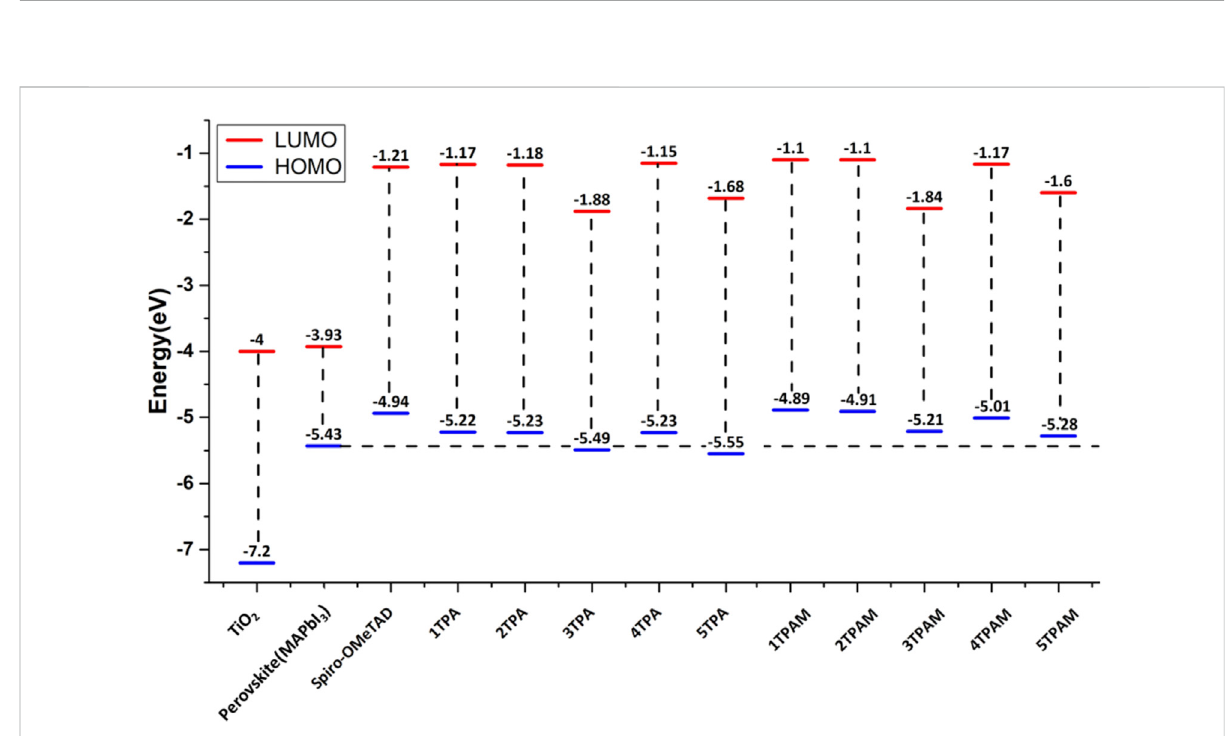
FIGURE 7 Comparison of energy levels of TPA and TPAM derivatives calculated with